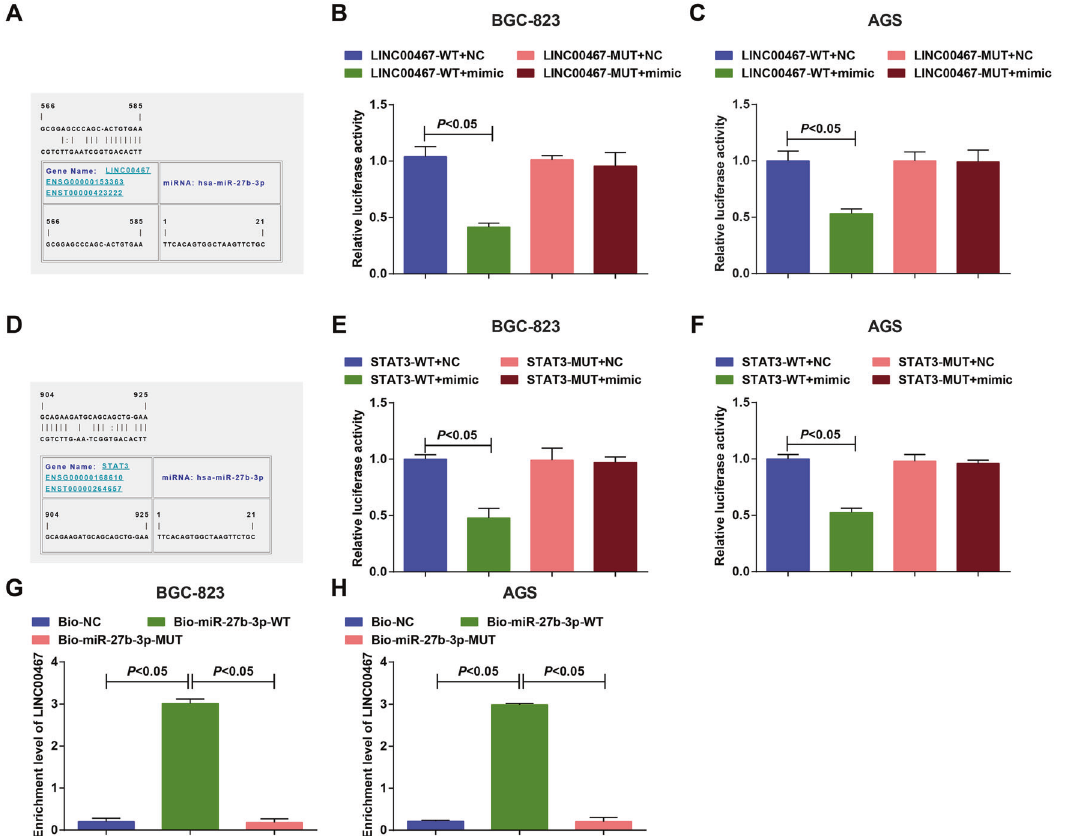
Fig. 7 LINC00467 serves as a ceRNA to sponge miR-27b-3p, thereby regulating STAT3. A Binding sites of LINC00467 and miR-27b-3p were predicted by bioinformatics website. B Regulatory relation between LINC00467 and miR-27b-3p in BGC-823 cells was con fi rmed by dual- luciferase reporter gene assay. C Regulatory relation between LINC00467 and miR-27b-3p in AGS cells was con fi rmed by dual-luciferase reporter gene assay. D Target relation between miR-27b-3p and STAT3 was predicted by bioinformatics website. E Target relation between miR-27b-3p and STAT3 in BGC-823 cells was con fi rmed by dual-luciferase reporter gene assay. F Target relation between miR-27b-3p and STAT3 in AGS cells was con fi rmed by dual-luciferase reporter gene assay. G Binding relation between LINC00467 and miR-27b-3p in BGC-823 cells was con fi rmed by RNA pull-down assay. H Binding relation between LINC00467 and miR-27b-3p in AGS cells was con fi rmed by RNA pull- down assay; N = 3; the measurement data were expressed as mean ± standard deviation. AGS cells were classi fi ed into seven groups as well and transfected with cells. Six-hour later, the medium was replaced. Cells were obtained 48 h pcDNA-LINC00467, pcDNA-LINC00467 NC, miR-27b-3p inhibitor, inhibitor NC, after culture. pcDNA-LINC00467 + miR-27b-3p mimic, or pcDNA-LINC00467 + mimic NC. These nucleotide sequences were purchased from GenePharma Co., Ltd. RT-qPCR (Shanghai, China). After seeding onto 12-well plates for 24 h, cells were The RNA extraction kits (Promega Corporation, WI, USA) were adopted for transfected. Lipofectamine 2000 (Invitrogen Inc., CA, USA) was utilized to total RNA extraction. An ultraviolet spectrophotometer (Thermo Fisher mediate the transient transfection of the sequences into BGC-823 and AGS Cell Death Discovery (2022)